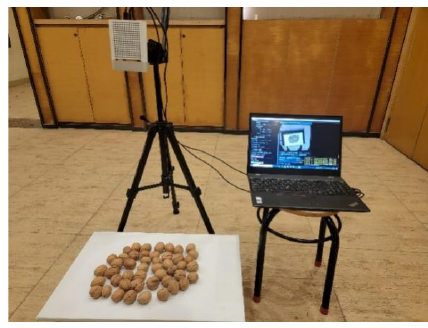
Figure 1. Proposed measurement